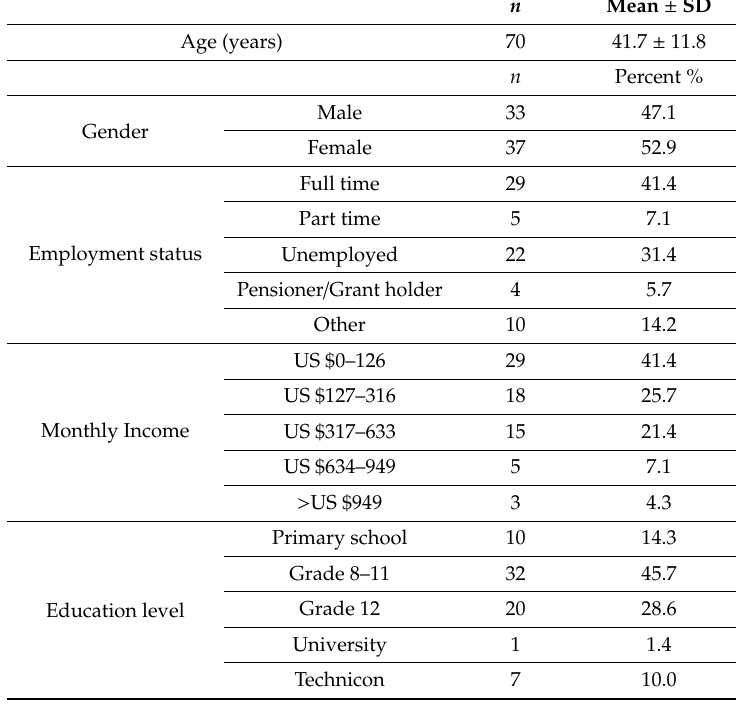
Table 1. Sociodemographic profile of participants.